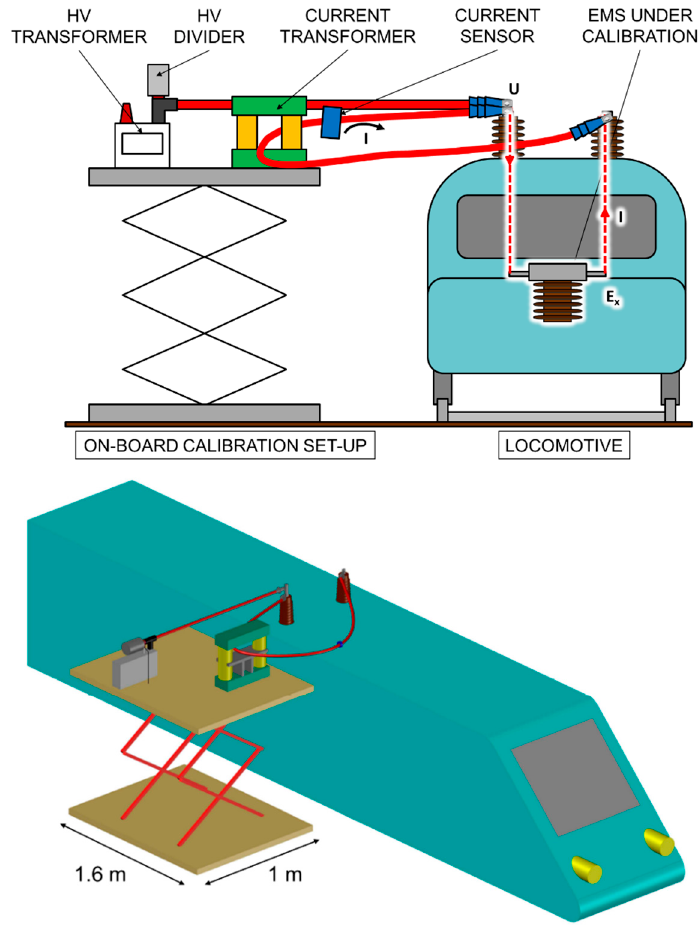
Figure 9. On-board calibration setup.